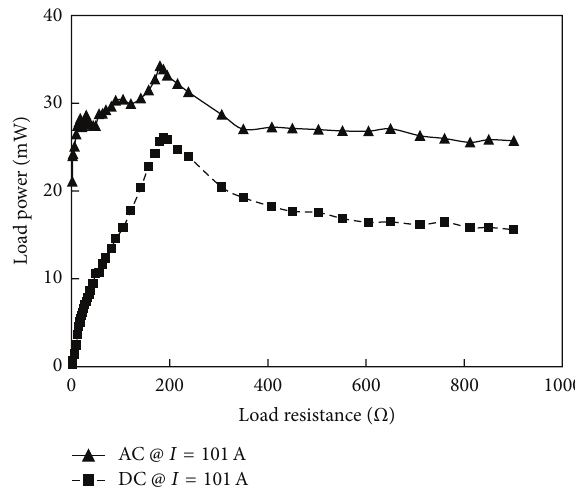
Figure 24: Load power before and after rectification when the prototype-5 is operating at a cable current level of 101A.